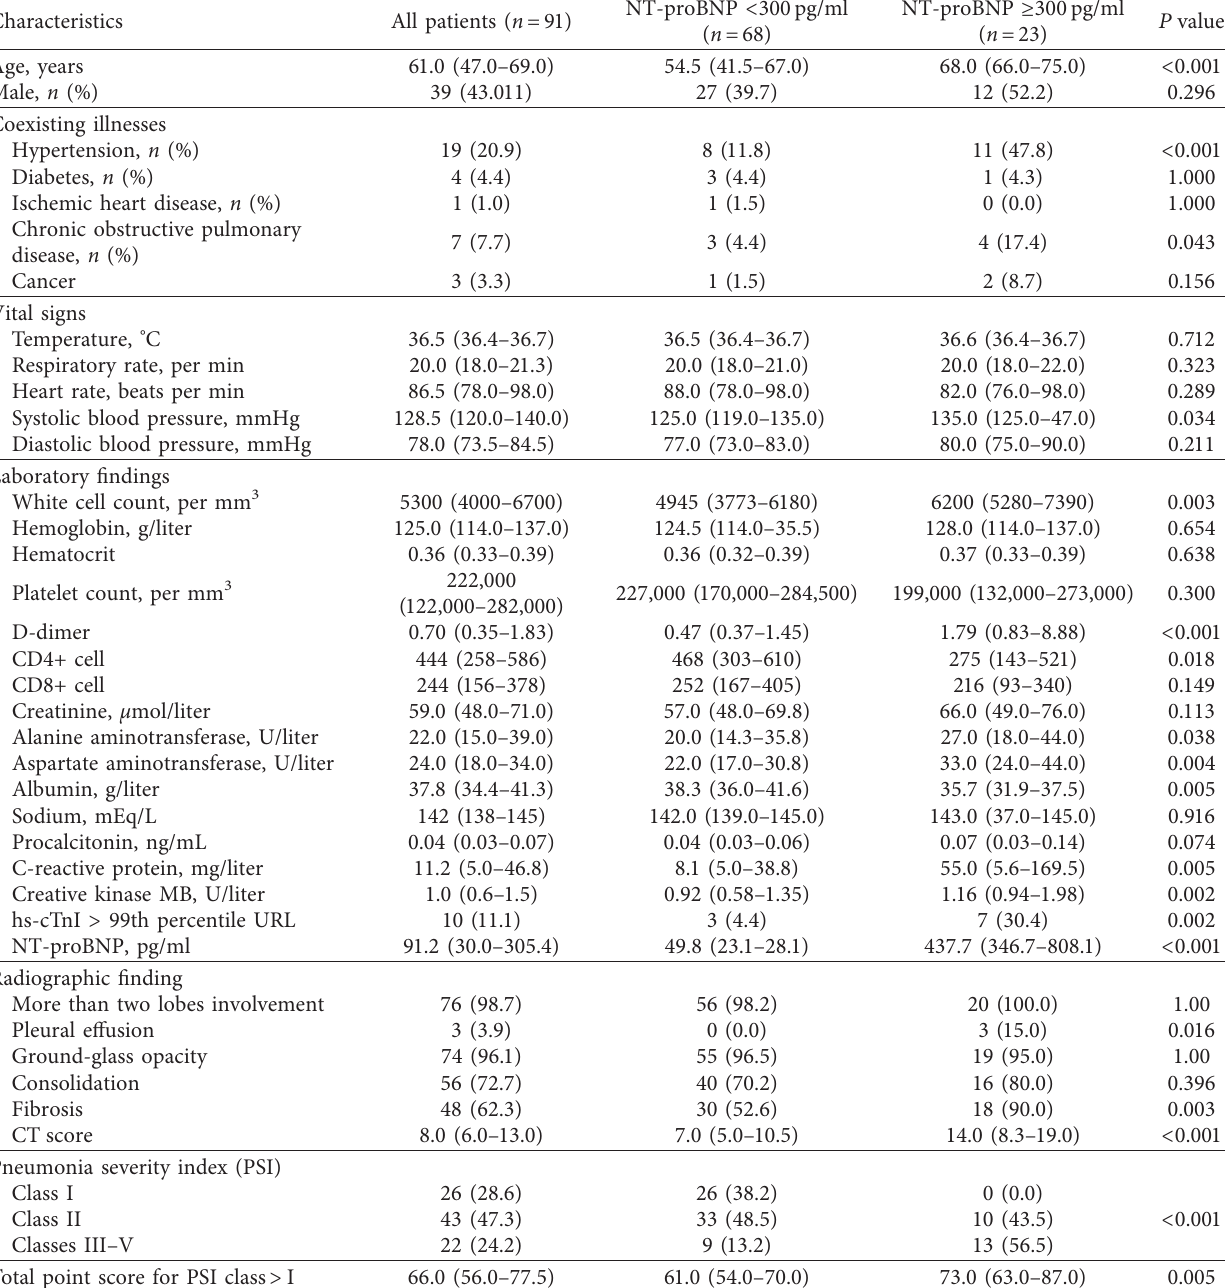
Table 1: Characteristics of patients at